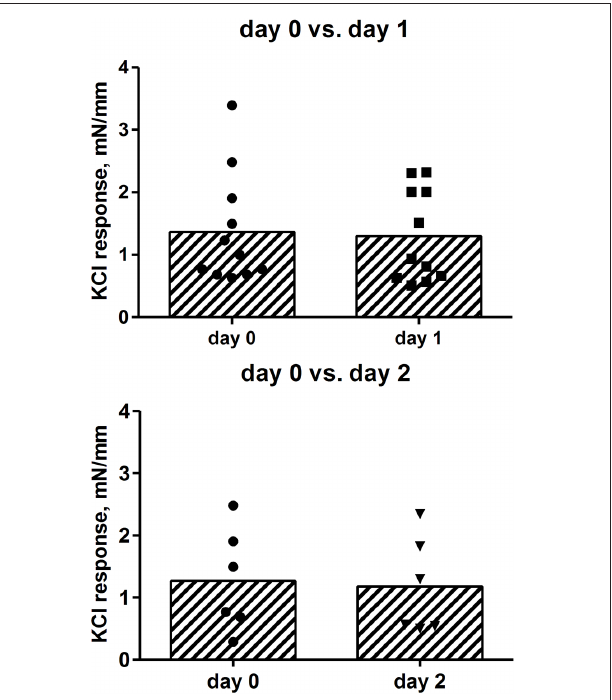
Figure 2 | effect of storage on contractile responses to 50 mM KCl. Strips were tested on the day of surgical removal (day 0) or 1 or 2 days later (day 1 and 2). Each data point represents one patient (16 and 15 strips, respectively, from 11 patients for the day 0 vs. 1 comparison; 10 and 10 strips, respectively, from 6 patients for the day 0 vs. 2 comparison), whereas the bars represent the group means. Note that the day 0 patients in the upper panel are not necessarily the same as in the lower panel, as each panel only shows patients for whom data on both days were